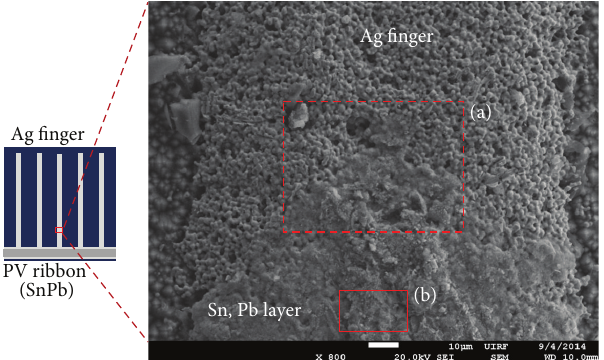
Figure 2: SEM image of Sn and Pb precipitation on the Ag finger. (a) Area indicates EDS mapping imaged in Figure 3; (b) FIB area imaged in Figure